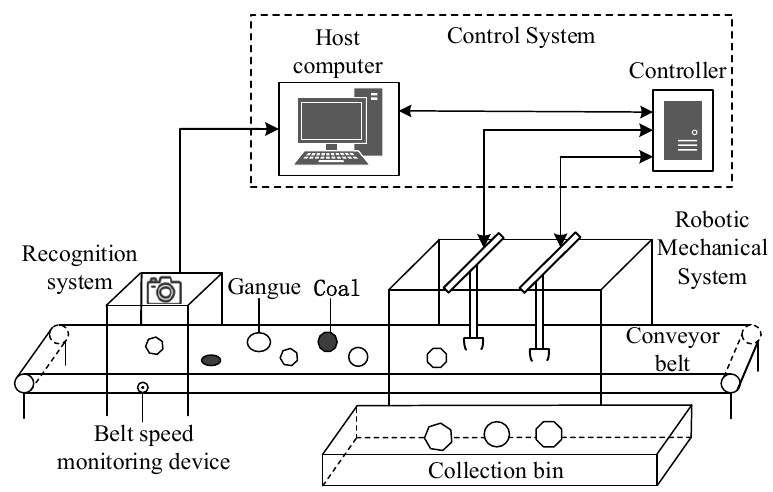
Figure 1. Multi-arm coal and gangue sorting robot system.